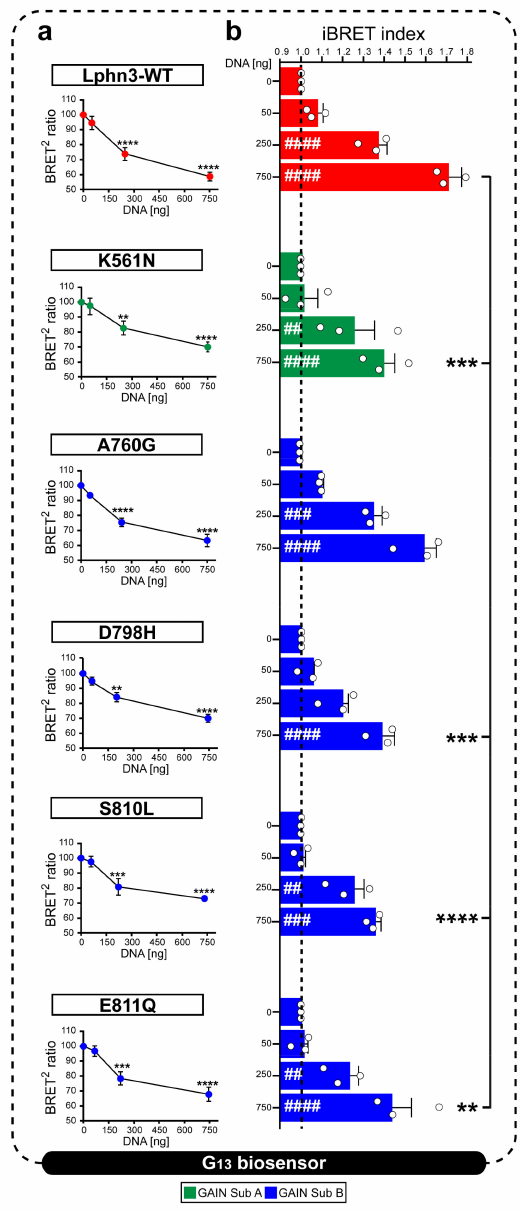
Figure 4. Lphn3 signaling through G13 protein is impaired by cancer-related GAIN domain